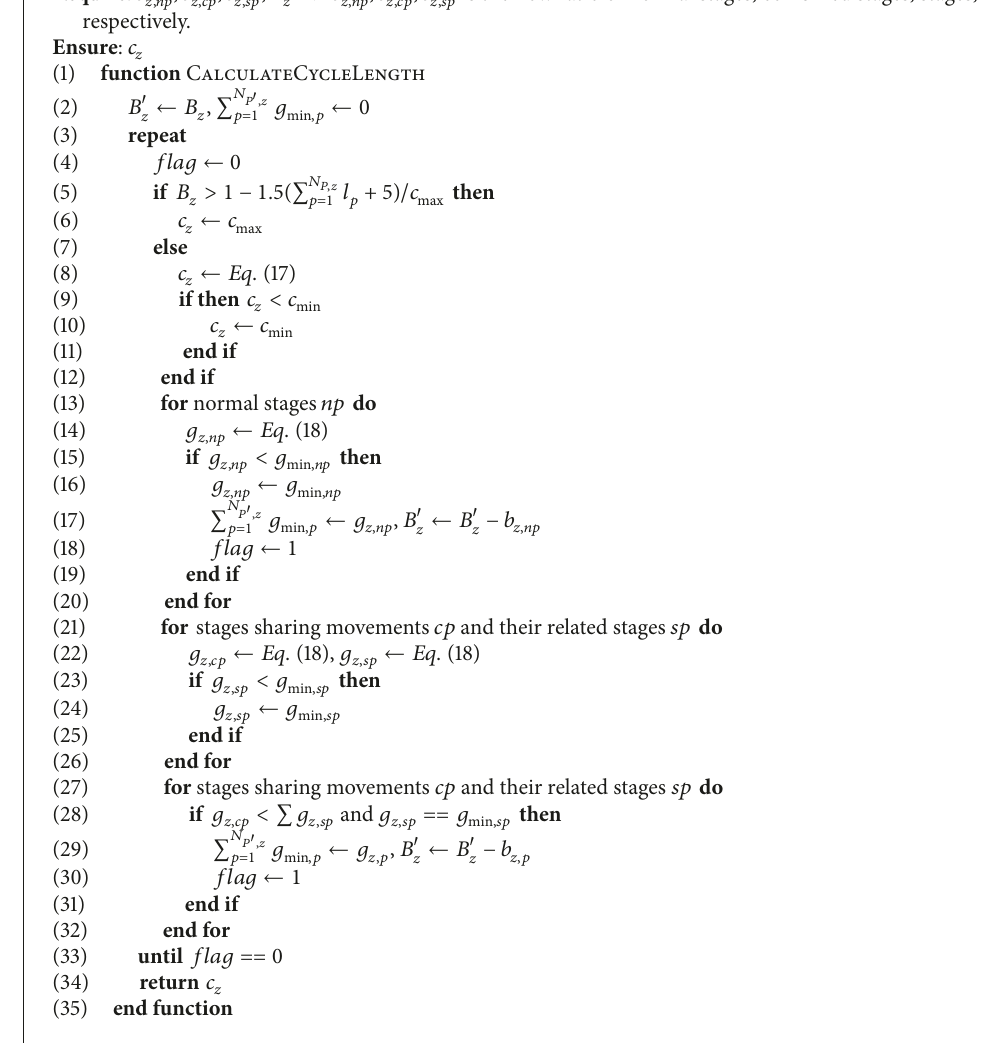
Algorithm 1: Calculation of cycle length for intersection 𝑧